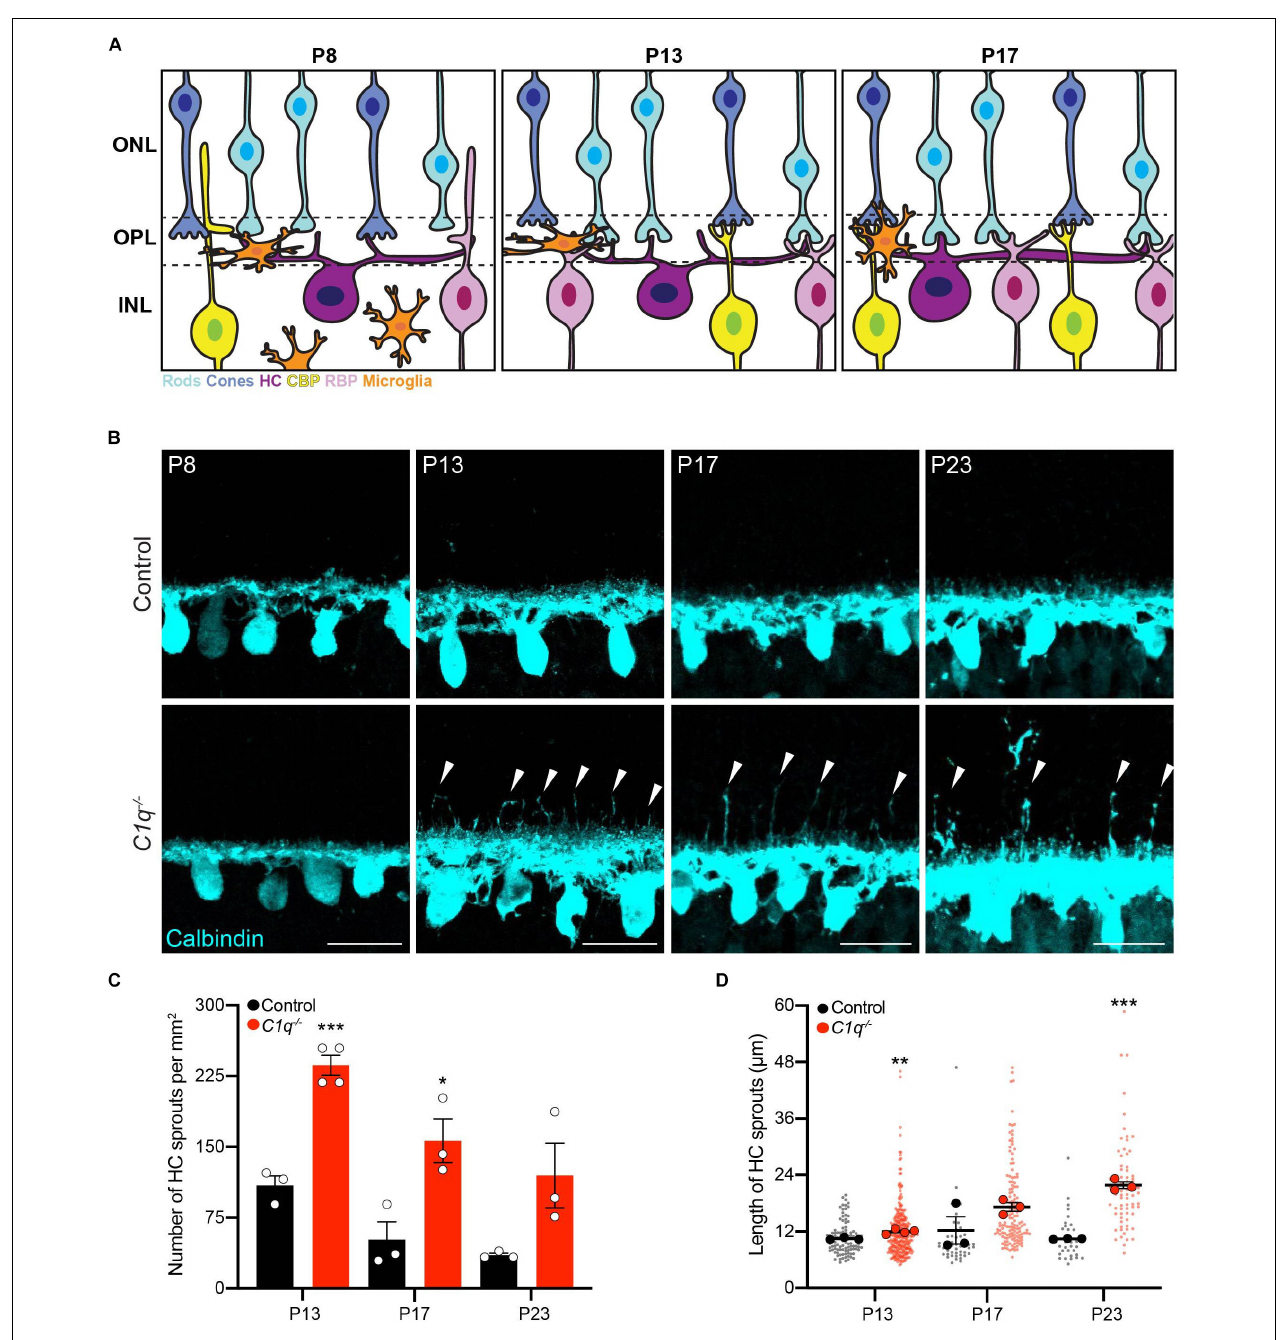
FIGURE 1 | C1q regulates horizontal cell neurite confinement . (A) Schematic of outer retina neuron and microglia organization during the second postnatal week. The outer nuclear layer (ONL) contains cones (blue) and rods (cyan) that form connections in the outer plexiform layer (OPL) with horizontal cells (purple), rod bipolar cells (pink), and cone bipolar cells (yellow) located in the inner nuclear layer (INL). At P8, microglia are migrating toward the OPL in concert with cone synapse maturation and rod synapse formation. At P13, microglia reside in the OPL, eye opening occurs, and ribbon synapse maturation continues as outer retina synapses become active. At P17, microglia remain in the OPL as sublamination of rod and cone synapses is completed. (B–D) Representative images of horizontal cells ( B anti-calbindin, cyan) and quantification of ectopic horizontal cell neurites ( C,D ) in wild type control and C1q − / − mice at P8, P13, P17, and P23. Horizontal cells in C1q − / − mice fail to remain confined to the OPL, showing an increased number of ectopic neurites (arrowheads) that peak at P13 but remain present as development proceeds ( C , N ≥ 3 wild type control and C1q − / − mice). These neurites extend into the outer nuclear layer and grow longer over time ( D , n = 99 and 287 sprouts from three wild type control and four C1q − / − mice at P13; n = 47 and 142 sprouts from three wild type control and three C1q − / − mice at P17; n = 32 and 73 sprouts from three wild type control and three C1q − / − mice at P23). Scale bars = 25 µ m. Data are represented as the mean ± SEM (C) or as beeswarm SuperPlots (D) in which individual horizontal cell sprout values are presented together with the mean from each animal ± the SEM. *** p < 0.001, ** p < 0.01, * p < 0.05 using unpaired two-tailed Student’s t -test.